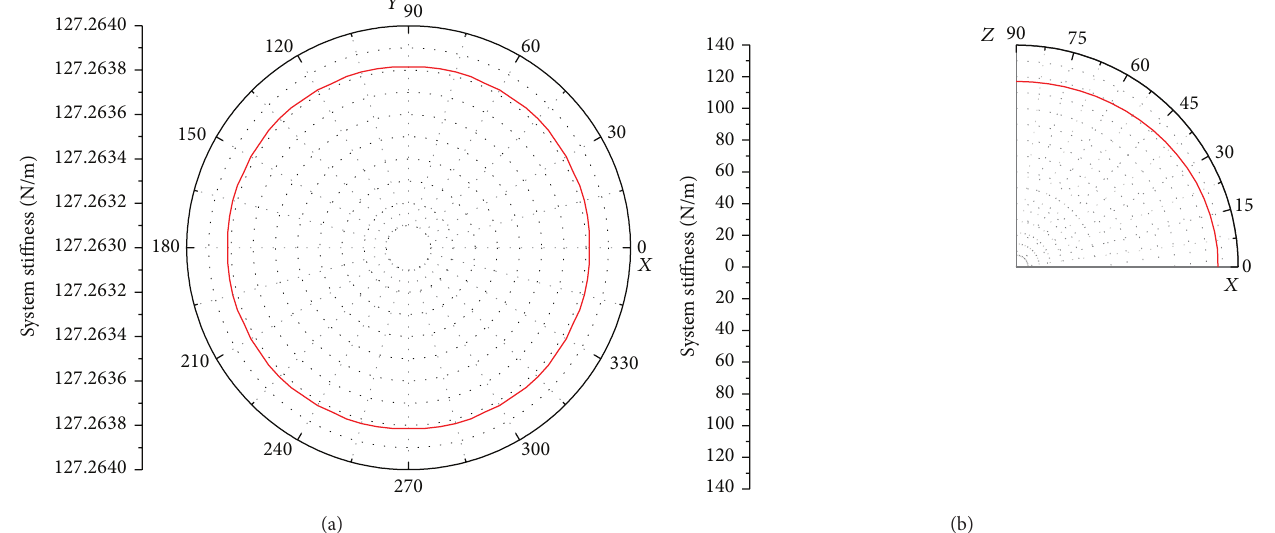
Figure 5: Simulated system stiffness distributions of the switch in the (a) XOY plane and (b) XOZ plane.